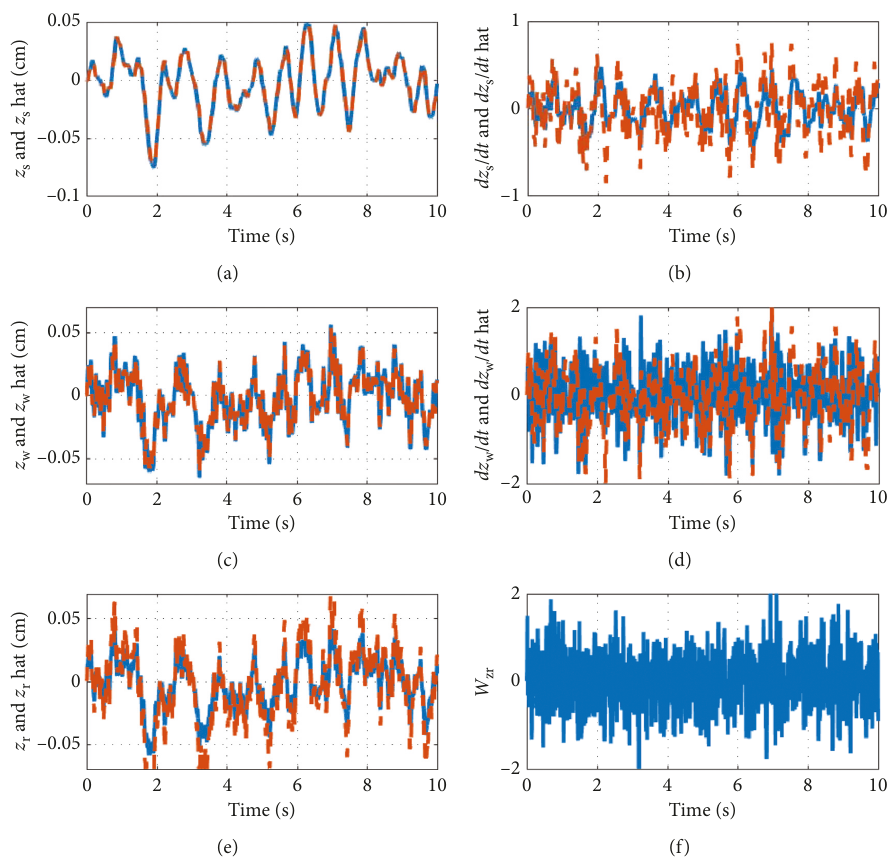
Figure 16: The real states (solid line) and estimated states using SPKF (dotted line) in the case of 80 km/h. (a) z dt hat. (c) z w and z w hat. (d) dz w / dt and dz w / dt hat. (e) z r and z r hat. (f) w